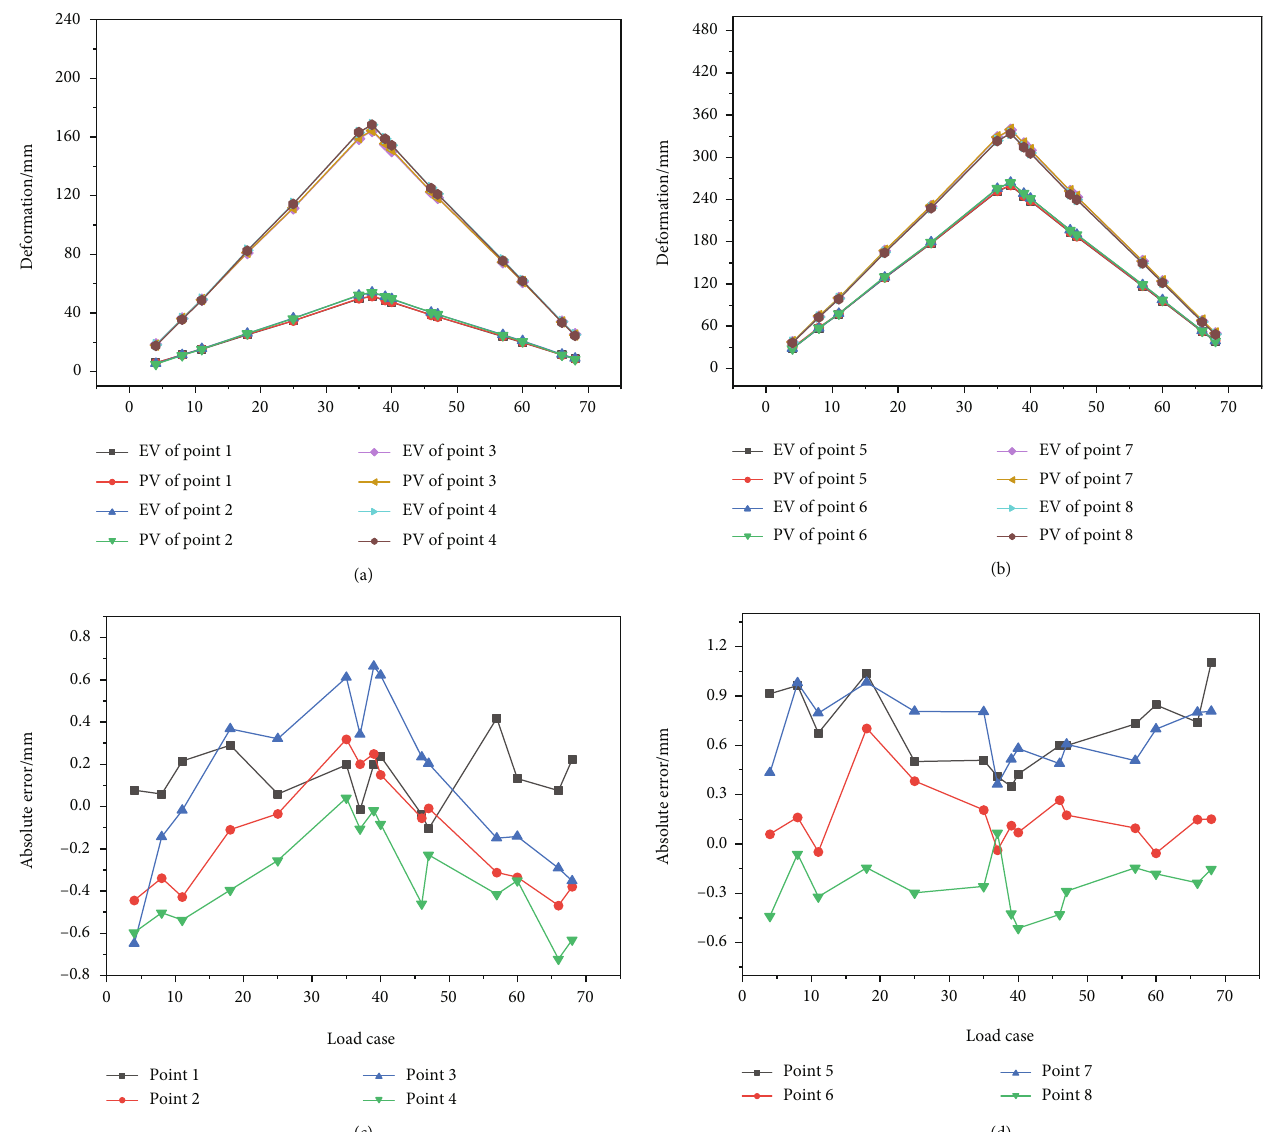
Figure 16: Comparison chart of displacement point prediction